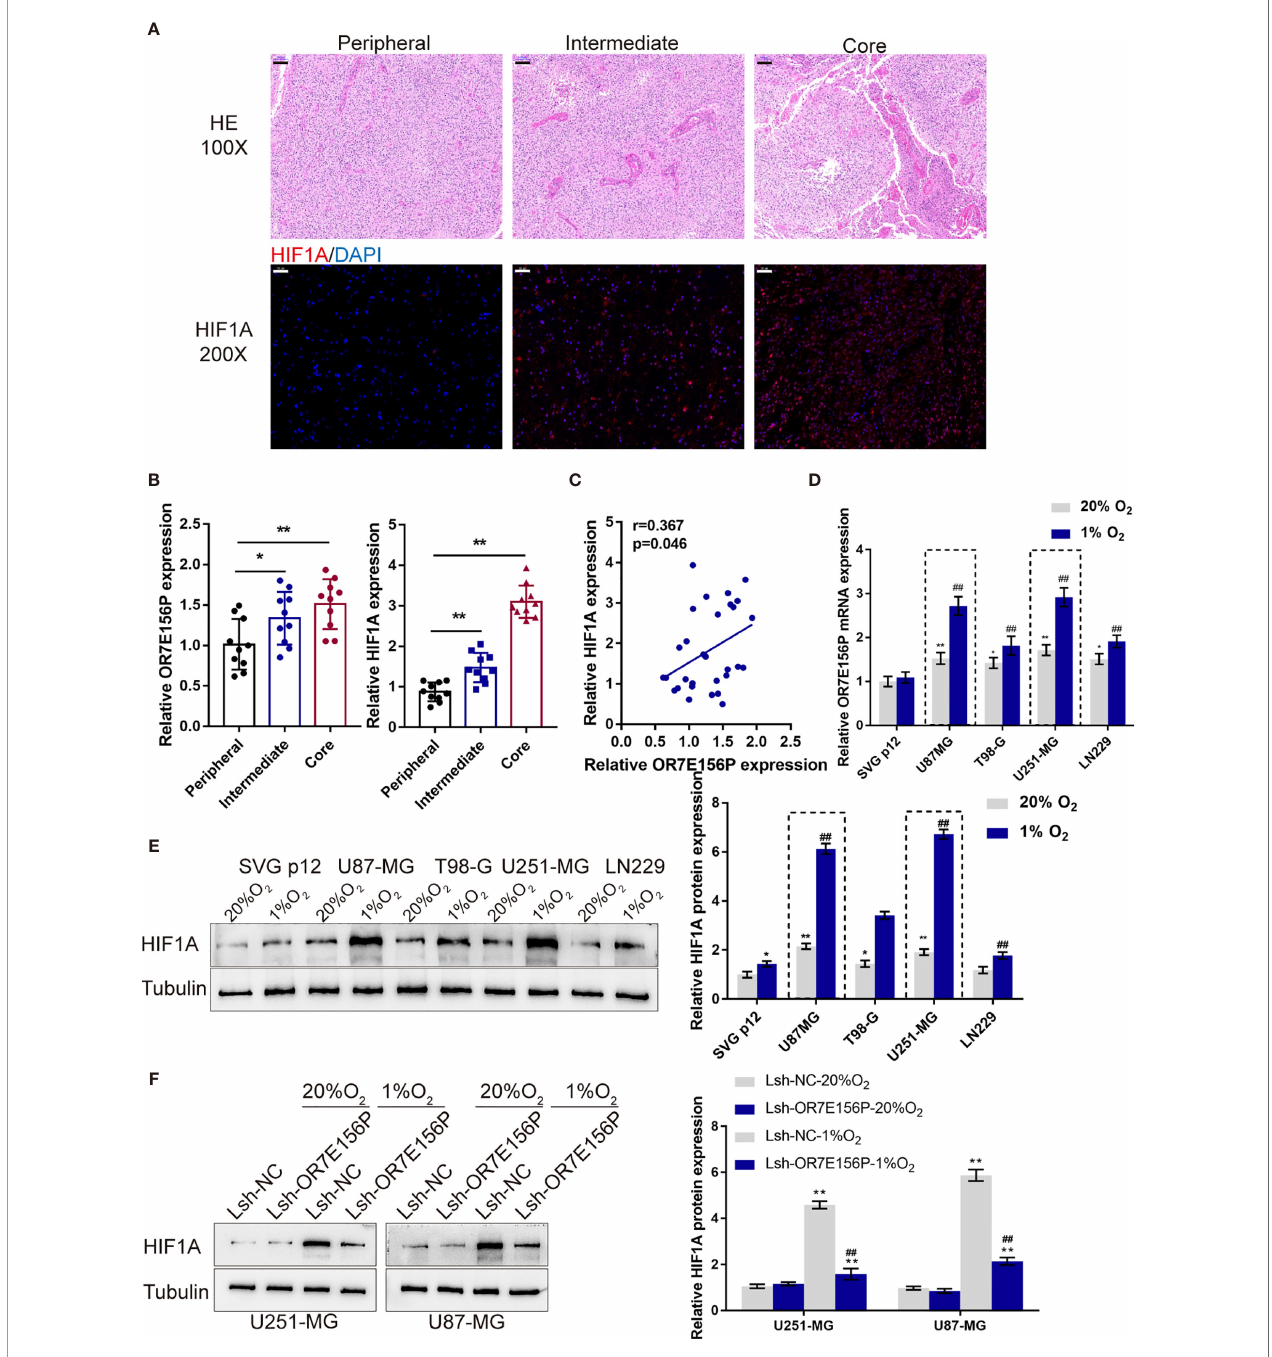
FIGURE 3 | Expression and association of OR7E156P and HIF1A under normoxia or hypoxia conditions (A) Glioma tissues samples from the core region, intermediate region, and the peripheral region were collected and examined by Hematoxylin and eosin (H&E) staining for histopathological characteristics and the immuno fl uorescence (IF) staining for the protein content and distribution of HIF1A. (B) The expression of HIF1A and OR7E156P in glioma tissues samples from the core region, intermediate region, and the peripheral region was examined using real-time PCR. (C) The correlation of HIF1A and OR7E156P expression in tissue samples was analyzed using Pearson ’ s correlation analysis. (D, E) A human fetal glial cell line SVG p12 and four glioma cell lines, U87-MG, T98-G, U251-MG, and LN229 were exposed to 1% or 20% oxygen and examined for the expression of OR7E156P using real-time PCR and protein levels of HIF1A using Immunoblotting. (F) U251-MG and U87-MG cells were transfected with Lsh-OR7E156P, exposed to 1% or 20% oxygen, and then examined for the protein levels of HIF1A by Immunoblotting. * P < 0.05, ** P < 0.01, ## P <